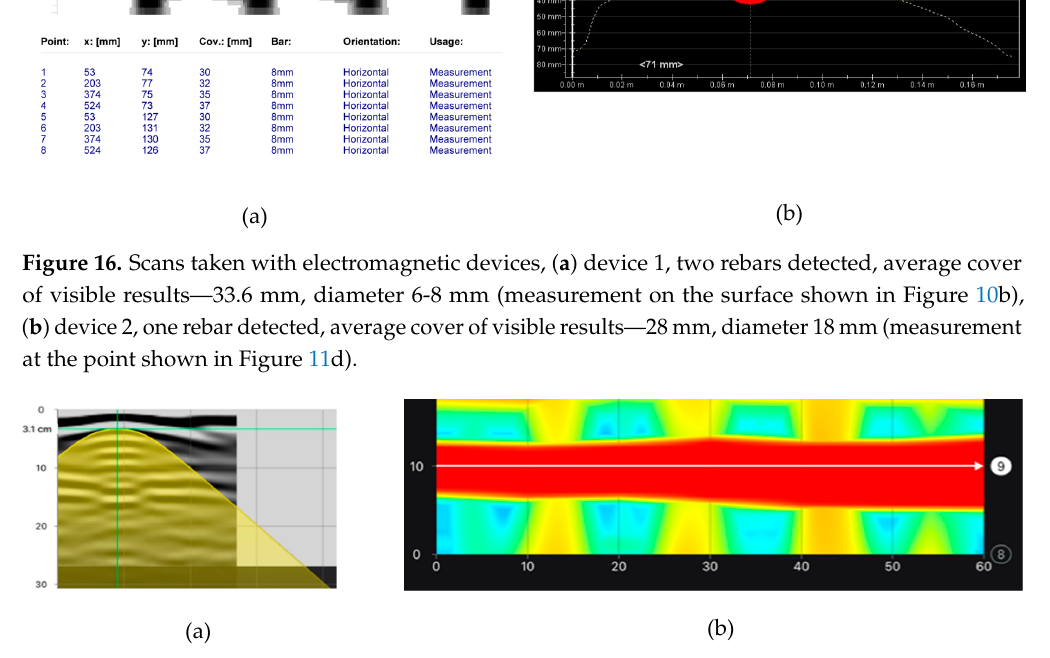
(i) Figure 18. Results from tests conducted with the electromagnetic device (1): ( a ) S-10-20 (result: two rebars, ø obs = 8 mm, c obs = 25 mm), ( b ) S-10-30 (three rebars, ø obs = 8 mm, c obs = 20 mm), ( c ) S-10-40 (three rebars, ø obs = 10 mm, c obs = 21 mm), ( d ) S-16-20 (two rebars, ø obs = 30 mm, c obs = 25 mm), ( e ) S-16-30 (three rebars, ø obs = 16 mm, c obs = 18 mm), ( f ) S-16-40 (three rebars, ø obs = 20 mm, c obs = 20 mm), ( g ) S-20-20 (three rebars , ø obs = 20 mm, c obs = 25 mm), ( h ) S-20-30 (three rebars, ø obs = 20 mm, c obs = 18 mm), and ( i ) S-20-40 (three rebars, ø obs = 20 mm, c obs = 22 mm)